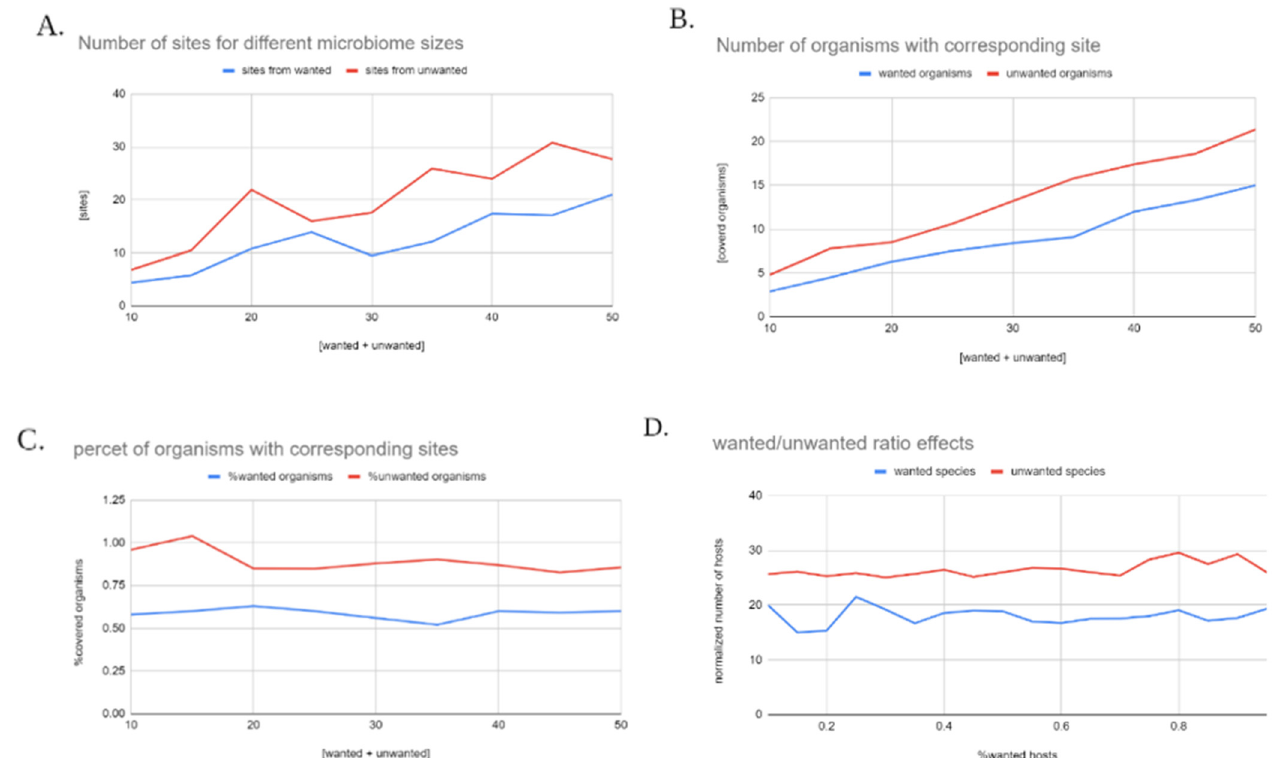
Figure 14. Characteristics of the engineered sequence. Random samples of 10 to 50 species were selected, and randomly split into 2 subgroups- of wanted organisms, and one of unwanted organisms. After applying the model to the defined microbiome: ( A ) exhibits the number of sites incorporated in the final sequence from each one of the two groups; ( B ) exhibits the number of organisms that have a corresponding site; ( C ) exhibits the percent of organisms that have a corresponding site; and ( D ) exhibits the normalized presence or restriction sites recognized by the wanted and unwanted hosts. For each ratio, the number of species that have a site recognized by a restriction enzyme was calculated for both groups and divided by the total number of species in the group for the sake of normalization. 30 species were randomly chosen and split into wanted and unwanted hosts according to the presented ration the exhibited results are an average of 10 runs in each condition.